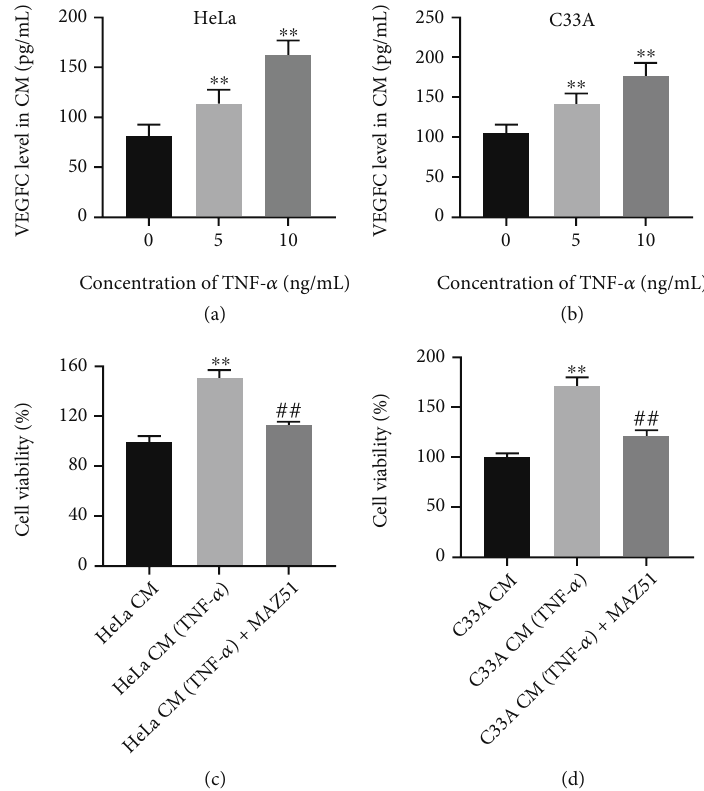
Figure 1: TNF- α stimulates cervical cancer cells to secrete VEGFC and promotes HLEC viability. (a, b) Cervical cancer cells (HeLa and C33A) were stimulated with di ff erent concentrations of TNF- α (0, 5, or 10ng/ml) for 48 h, and corresponding CM was collected. Next, the level of VEGFC in the corresponding CM was detected by ELISA. (c, d) HLECs were cultured in CM with or without MAZ51 treatment. HLEC viability was measured by CCK-8 assay. ∗∗ P < 0 : 01 compared with CM group; ## P < 0 : 01 compared with CM-TNF- α group, n = 3